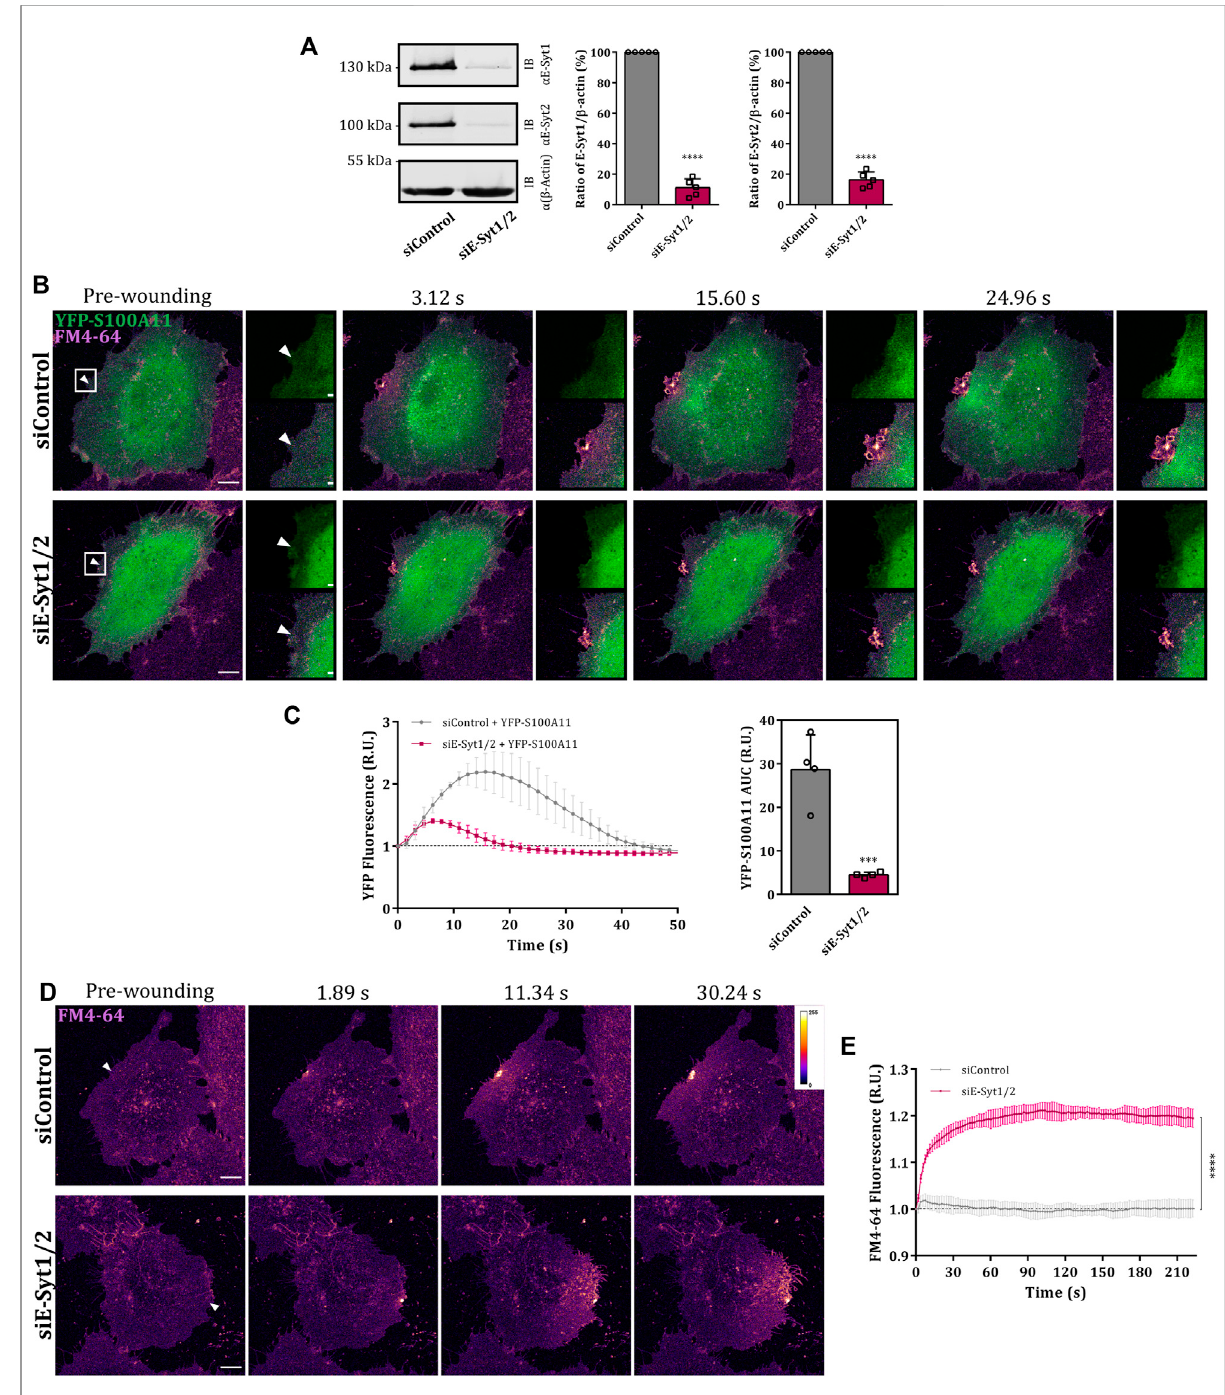
FIGURE 7 E-Syt1 regulates translocation of S100A11 to plasma membrane wounds. (A) Immunoblot analysis of endogenous E-Syt1 (124 kDa) and E-Syt2 (102 kDa) expression inHUVEC transfected with control orE-Syt1and E-Syt2-speci fi csiRNAs (siControlor siE-Syt1/2, respectively). β -actin(42 kDa) is shown as the loading control. Representative blots from fi ve independent experiments are shown. Ef fi ciencies of E-Syt1 and E-Syt2 knockdown quanti fi ed in fi ve independent blots are also shown. Statistical comparisons between non-targeted and targeted knockdowns were performed with two-tailed Student ’ s t test. (B) Time-lapse images of S100A11 recruitment to laser-induced plasma membrane wounds in siControl or siE-Syt1/ 2 treated HUVEC (Supplementary Video S12). Cells kept in Tyrode ’ s buffer supplemented with 2.5 mM Ca 2+ and 5 μ g/ml FM4-64 were injured at the lateral membrane edge (white triangles represent the wound sites). Wounding occurred at t = 0; pre-wounding and post-wounding time points are shown. Scale bars = 10 µm. Insets highlight the immediate vicinity around the wound. Scale bars = 2 μ m. (C) Time course of